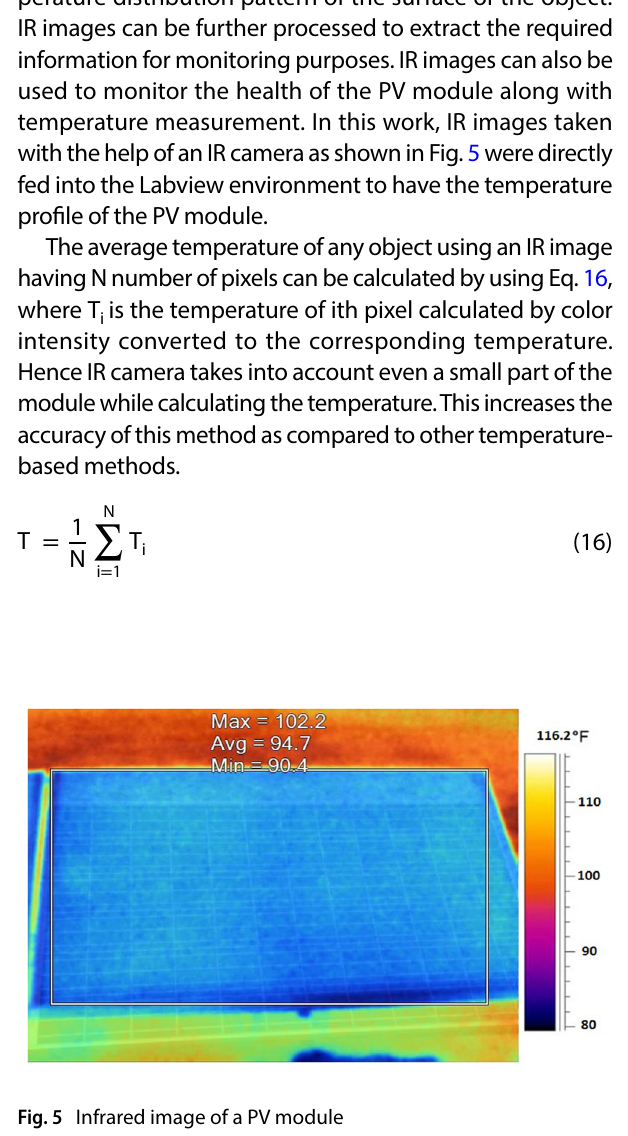
Fig. 5 Infrared image of a PV module Fig. 6 SIMULINK Model of proposed